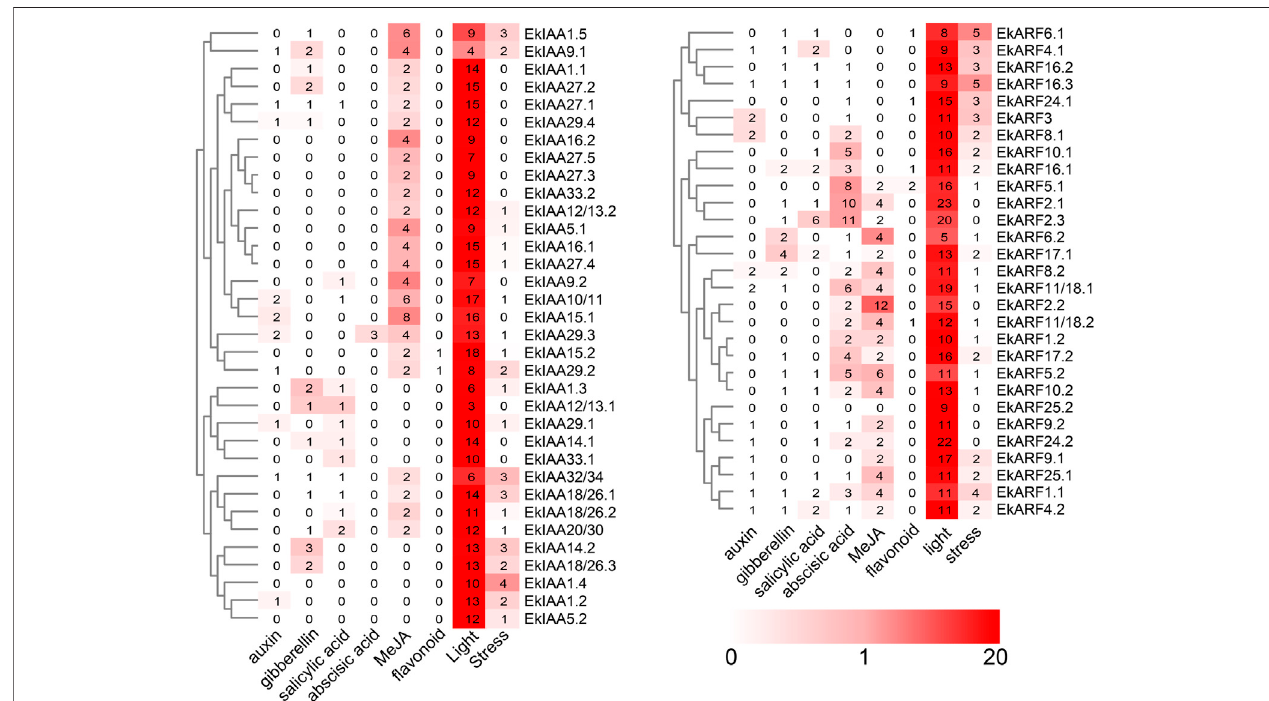
FIGURE 5 | Predicted cis -elements in the EkIAA and EkARF promoters. The promoter sequences ( − 2,000 bp) of 34 EkIAA and 29 EkARF genes were analyzed by PlantCARE. The color bar indicates the number of cis